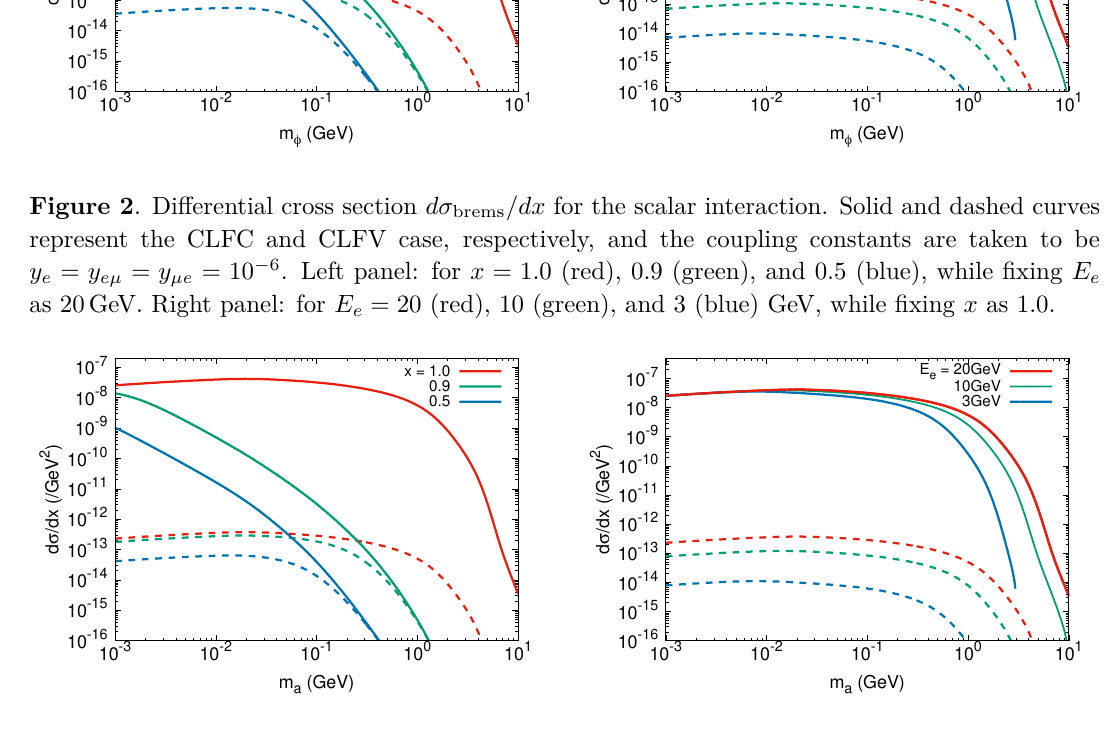
Figure 3 . The same plots as figure 2 for the pseudoscalar interaction. The coupling constants are taken to be c ee / Λ = 10 − 3 GeV − 1 and c eµ = c µe = 10 − 2 c ee . η ’ η , therefore the CLFC and CLFV cross sections asymptotically approach to each µ e other. In the right panel, the CLFC differential cross sections with x = 1 are similar to different E while the CLFV ones change order of magnitudes. For x = 1 , eq. (3.2) for e